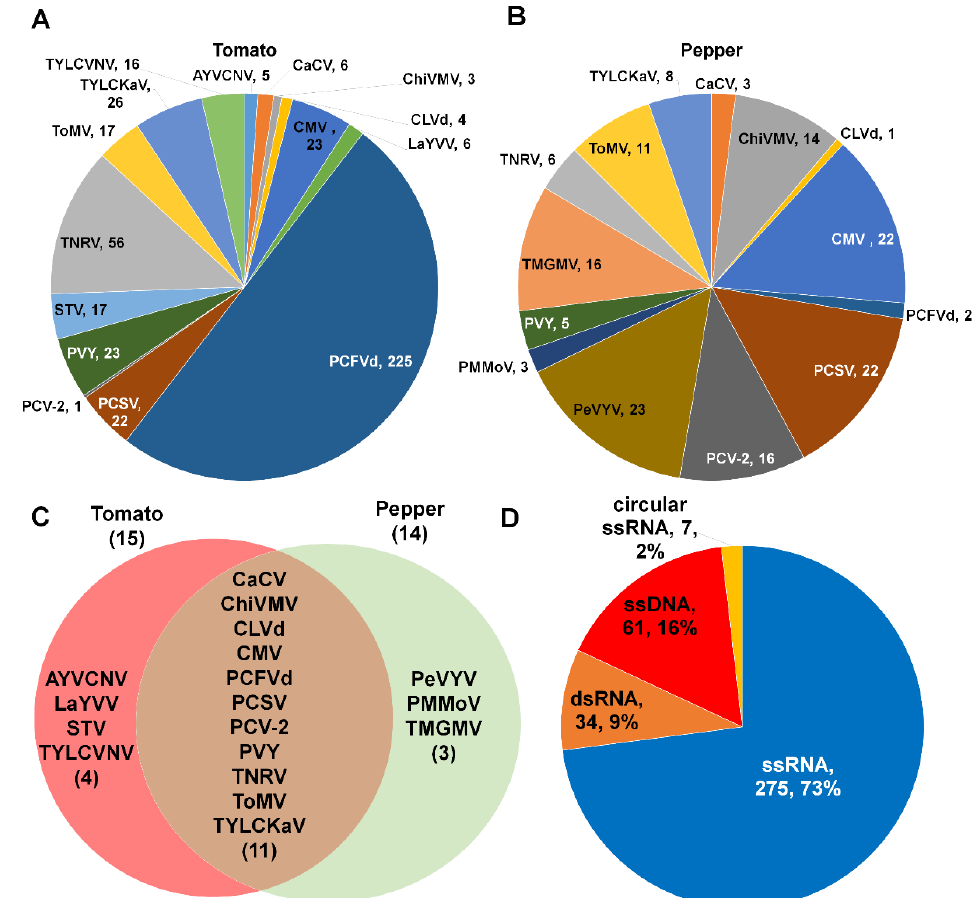
Figure 3. Number of virus-associated contigs for individual identified viral pathogen. The pie charts display the number of virus-associated contigs for identified viruses and viroids infecting tomato ( A ) and pepper ( B ) plants. ( C ) Venn diagram displays a comparison of identified viral pathogens between tomato and pepper plants. Full virus names can be found in Supplementary Table S1. ( D ) Proportion of identified viral pathogens according to viral genome type.